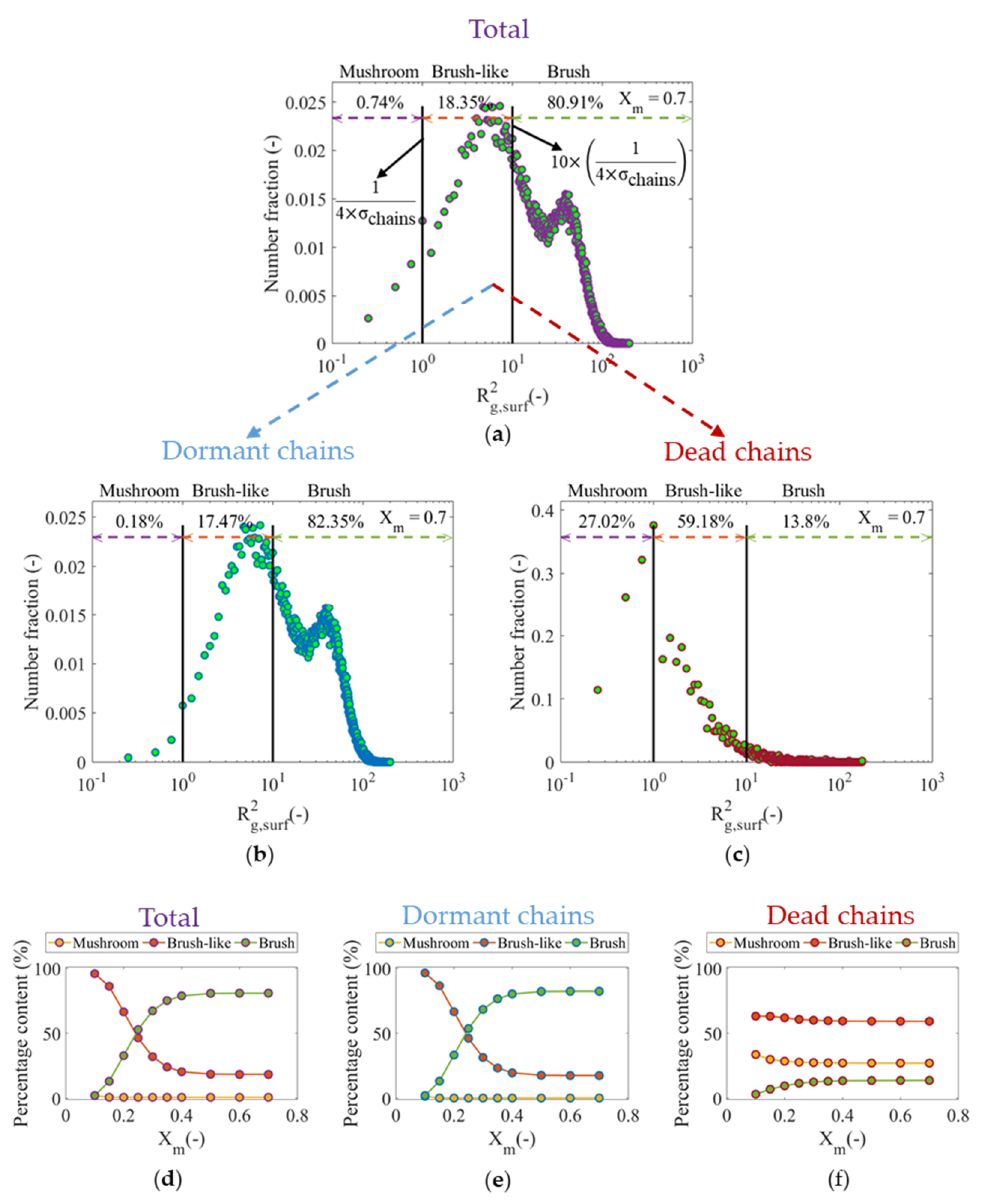
Figure 8. ( a ) Distribution of the squared radius of gyration ( R g,surf 2 ) of all individual surface-tethered polymer chains (purple-contoured full green circles) grown on the surface at a monomer conversion X m = 0.7. ( b ) Corresponding distribution for surface-tethered dormant chains (blue-contoured full green circles) and ( c ) dead polymer chains on surface (red-contoured full green circles). The two, black guide-of-the-eye vertical lines are calculated from Equations (1) and (3). Also shown are the associated percentages for mushroom, brush-like and brush chains; ( d – f ) these percentages are now given as a function of X m , differentiating between all chains (total), dormant and dead surface-tethered chains. Conditions as in Figures 4–7 (translational mode) and kinetic parameters in Table 1.